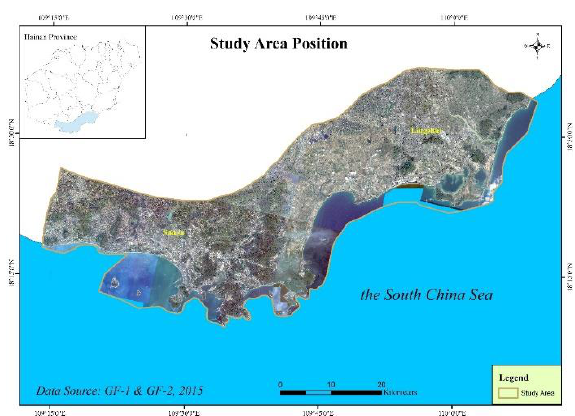
Figure 1. Remote sensing images of Study region